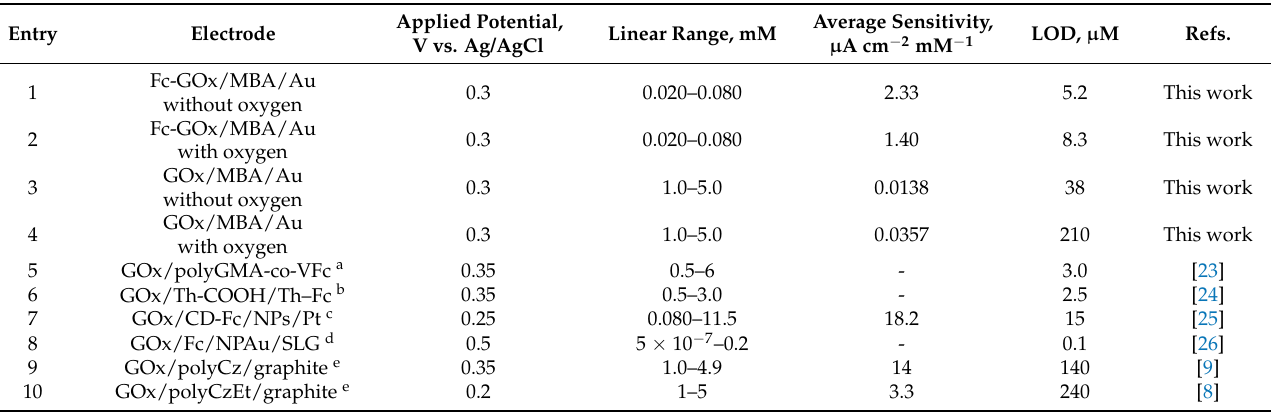
Table 1. Characteristics of our biosensors for glucose detection and the comparisons with other Fc, hole transporting organic semiconductors, and GOx-based biosensors in the